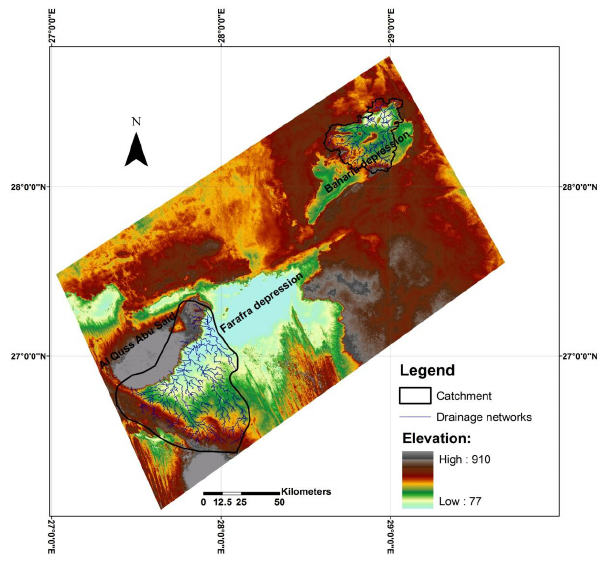
609 610 Fig. 5. The SRTM DEM and the automatically extracted drainage Fig 5: The SRTM DEM and the automatically extracted drainage networks for the 611 cultivated catchments within the study area. 612 networks for the cultivated catchments within the study 613 614